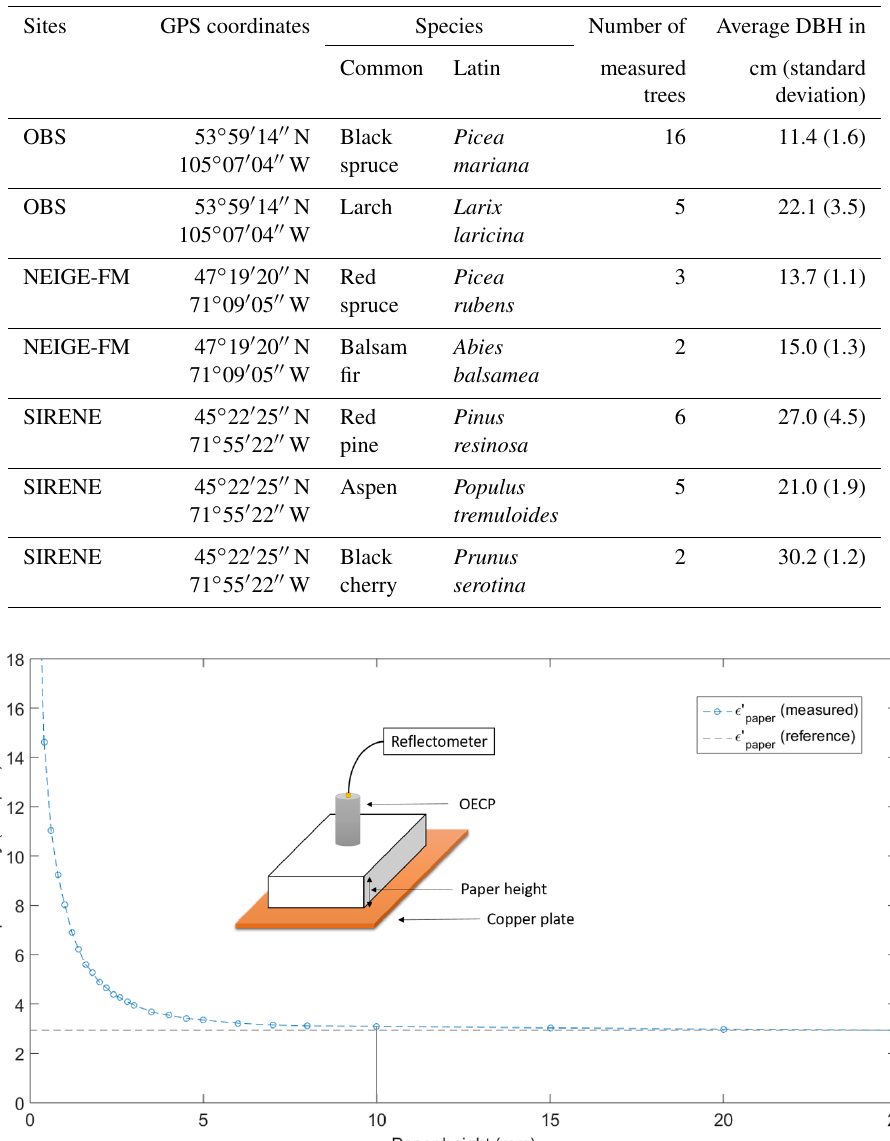
Figure 4. Real relative permittivity (unitless) at L band (1–2GHz averaging) of a stack of paper sheets. The permittivity imaginary part is provided in the Supplement (Fig.